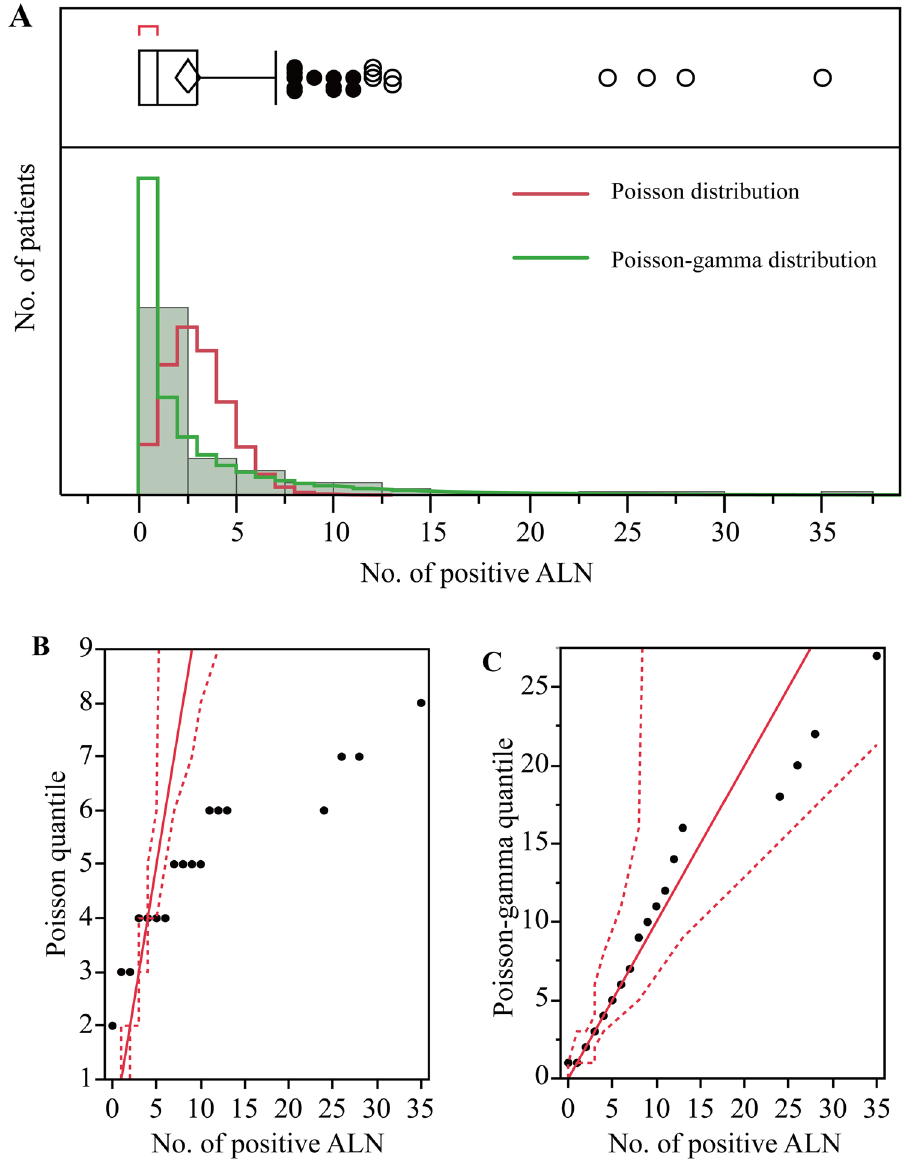
Figure 1. Distribution of metastatic axillary lymph node (ALN) counts. ( A ) Distribution of the metastatic ALNs. The counts of metastatic ALNs approximately follow a Poisson-gamma distribution. In the boxplot above the graph, the vertical line in the bottom of the box indicates the median, the diamond indicates the mean, and the left and right borders of the box mark the 25th and 75th percentiles, respectively. The solid point extending from the right of the box marks the end of 95th percentiles. The hollow points are outliers beyond the 95th percentile. ( B ) Goodness of fit with a Poisson distribution. The red line indicates the fit line and the dotted line shows the 95% confidence interval. ( C ) Goodness of fit with Poisson-gamma distribution. The red line indicates the fit line, and the dotted line shows the 95% confidence